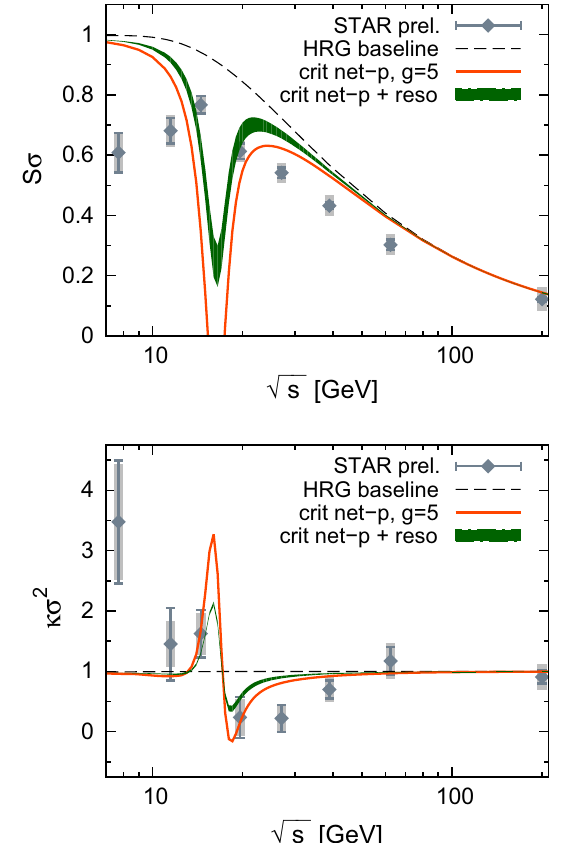
Fig. 3 Similar to Fig. 2, but including resonance decays both in the baselineresults( thindashedcurves ),cf.[31]formoredetails,andforthe case g = g p = 5. Resonance decays are found to reduce the influence ofcriticalfluctuationsonthenet-protonnumbercumulantratiosvisibly. The filled bands contain the results of the three different ansätze for g R discussed in this work: the strongest reduction of baseline deviations is seen for g R = 0 when resonances do not couple to the critical mode, while critical fluctuations are least suppressed by resonance decays for g R following the phenomenological ansatz Eq. (25). The case g R = g p lies in between, but closer to the phenomenological